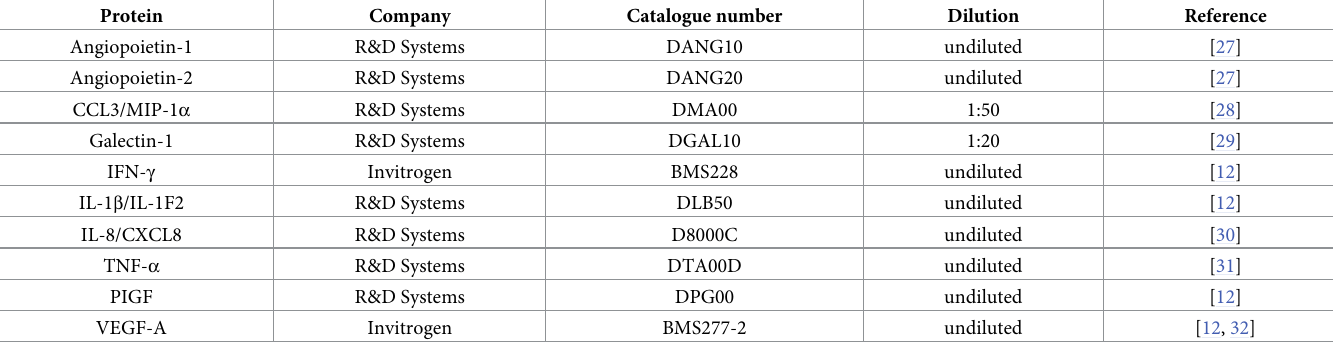
Table 1. Applied ELISA assays including company, catalogue number, dilution, and references.